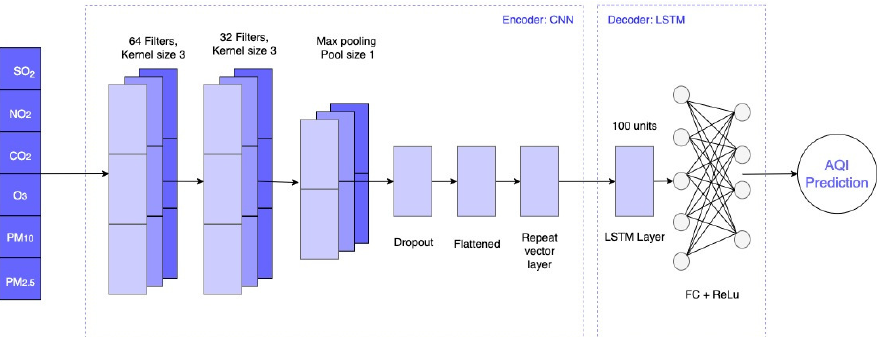
Figure 4. CNN-LSTM